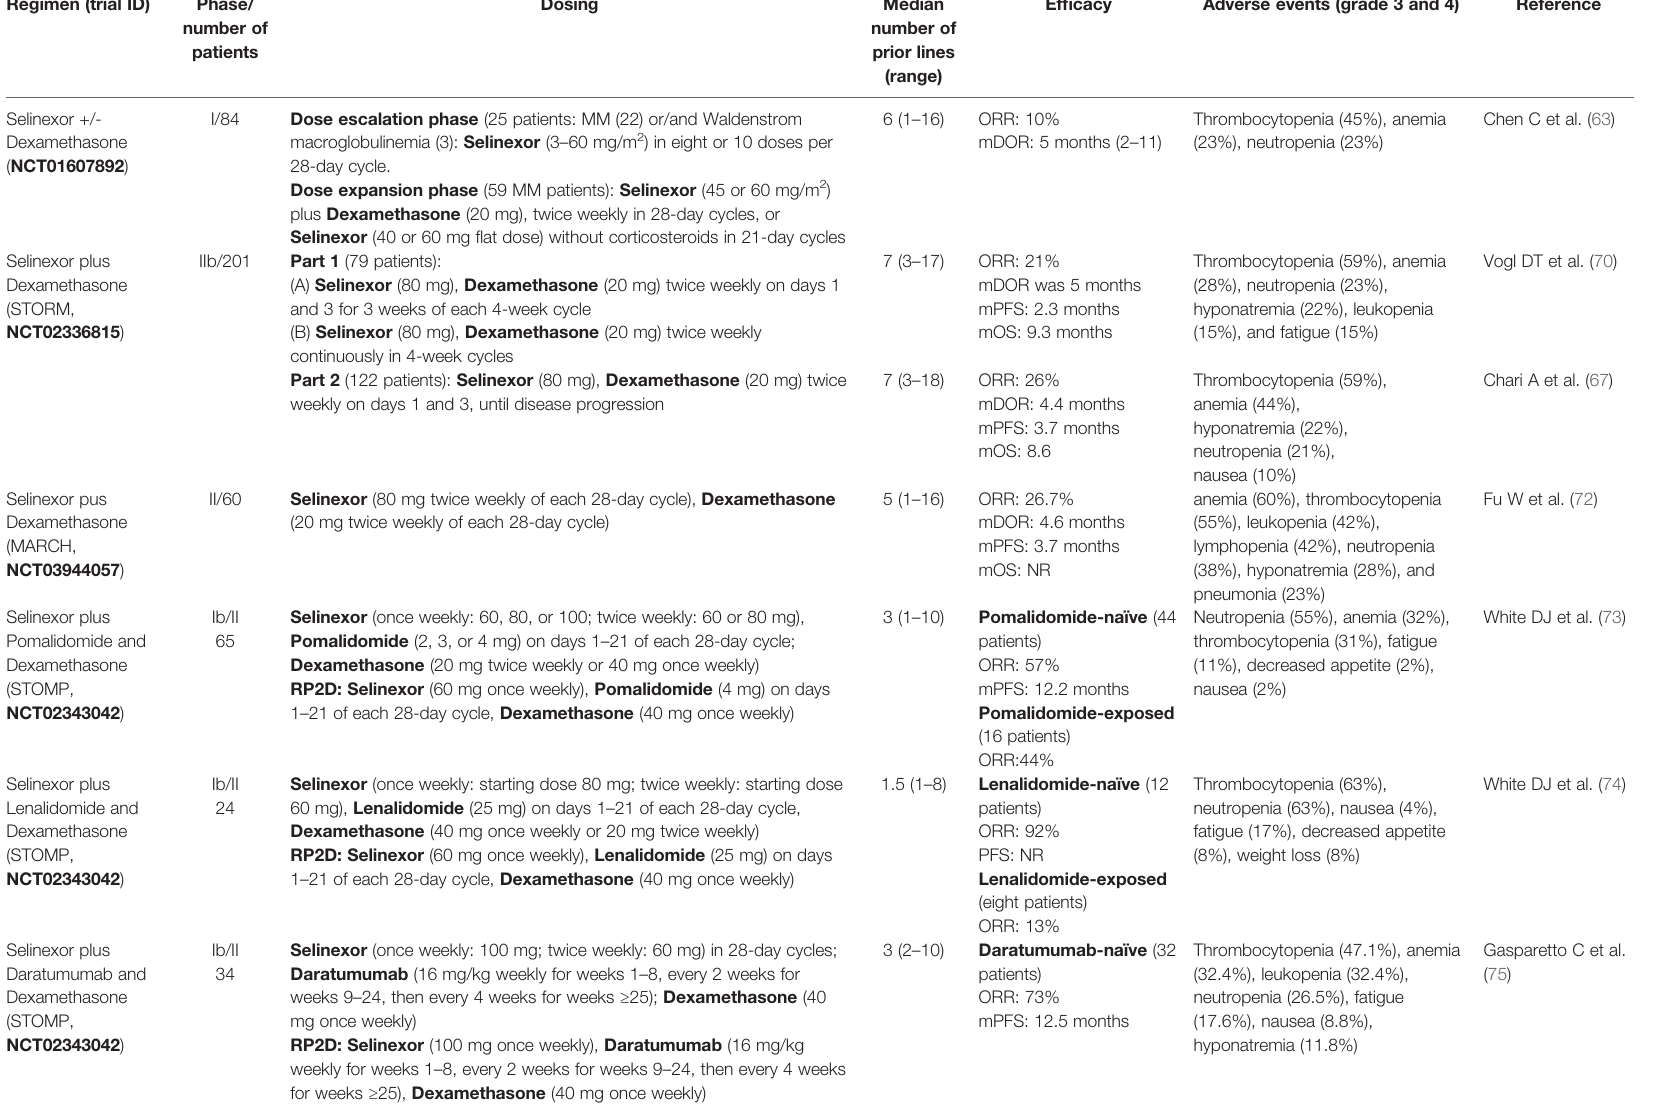
TABLE 3 | Summary of fi ndings of main clinical trials with Selinexor in relapsed/refractory multiple